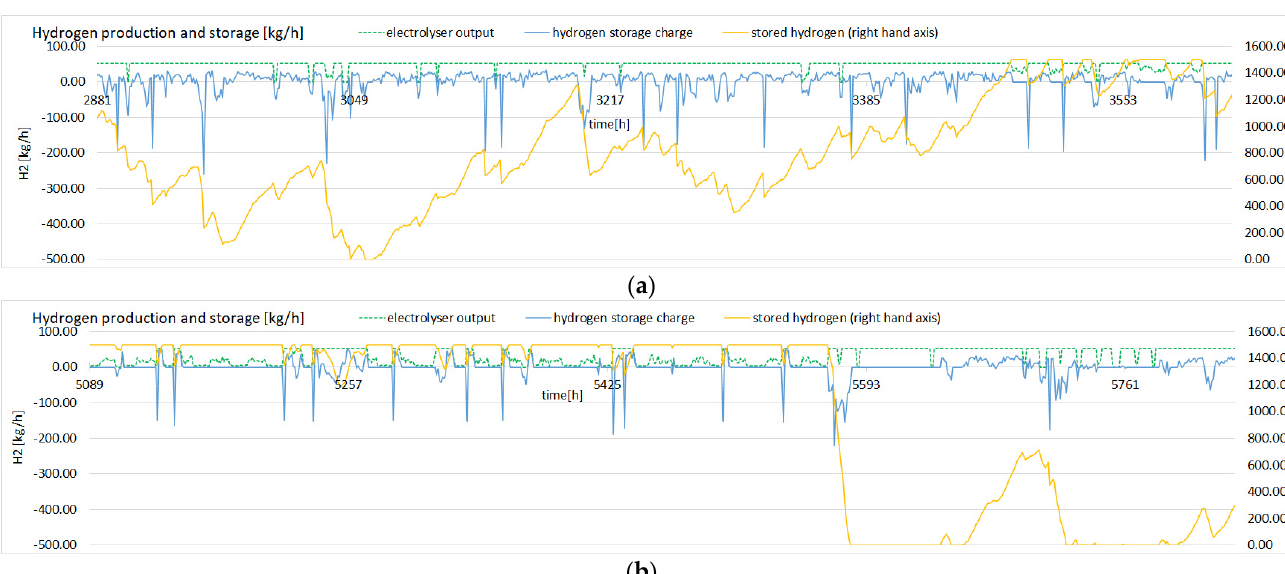
( b ) Figure 4. Case electric energy flows (simulation results). ( a ) May; ( b ) August. ( a )